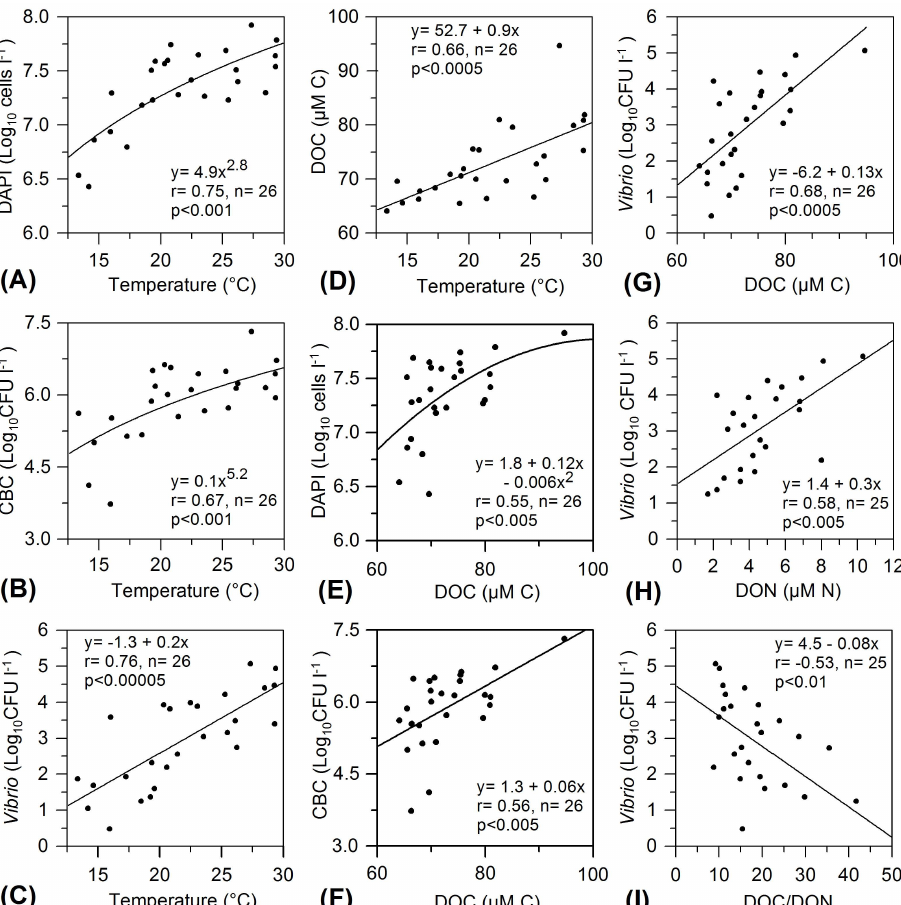
Fig. 5. Correlations between bacterial abundance and various biogeochemical factors in all surface water samples. The lines represent linear or curvilinear regressions between the two parameters. The regression equations and relevant statistical information are shown for each correlation. For abbreviations refer to Fig.